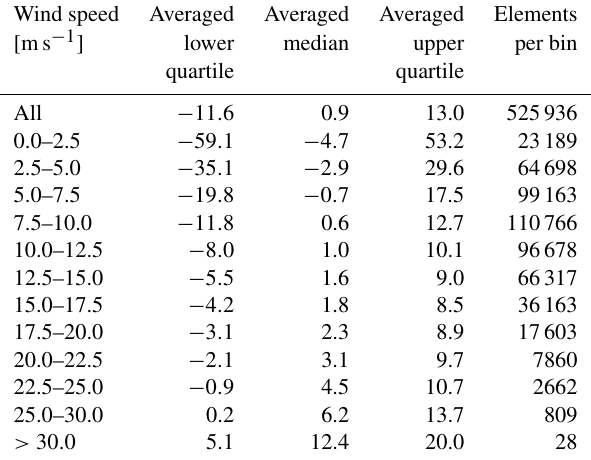
Table 2. Values of the percentiles for the wind direction changes (in ◦ ) with reference to FINO1 for different bins of wind speed at the reference location. The values are calculated as an average of all grid points in the offshore regions of the German Bight (gray area in Fig.